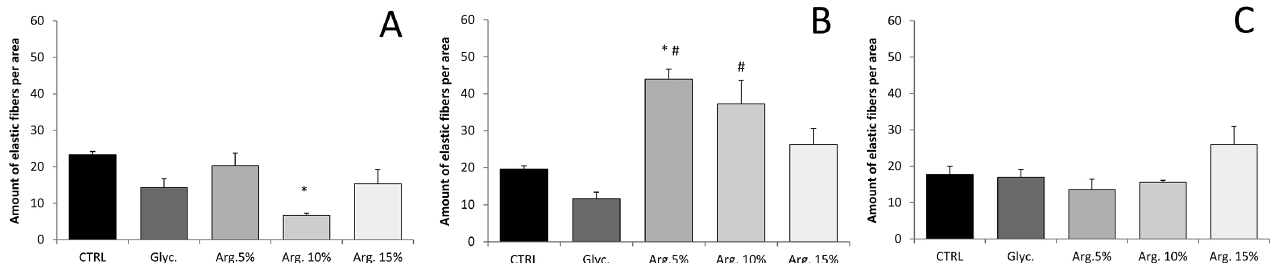
FIGURE 6 - Quantitative analysis of elastic fibers in male mouse skin. Mice from group 4 (A), group 5 (B), and group 6 (C) were treated with vehicle (Glyc.), L-arginine at 5% (Arg. 5%), 10% (Arg. 10%), or 15% (Arg. 15%), or did not receive any treatment (CTRL). P < 0.05, * versus CTRL, # versus Glyc.; (3 ≤ n ≤